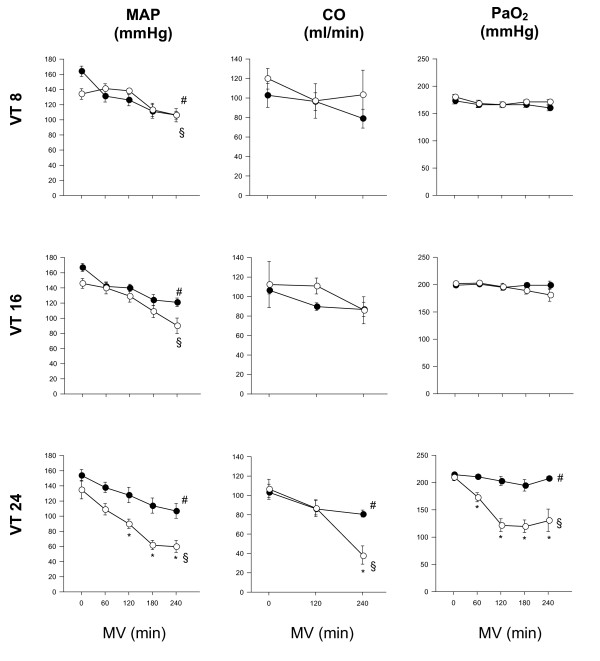
Cardio-respiratory parameters in old and young mechanically ventilated rats. Mean arterial pressure (MAP), cardiac output (CO) and arterial oxygen tension (PaO2) in old (white circles) versus young (black circles) rats in minutes after initiation of mechanical ventilation (MV) with tidal volume (VT) of 8, 16 or 24 ml/kg body weight, respectively. * = P <0.05 old vs. young animals; #, § = P <0.05 time point vs. start of MV.